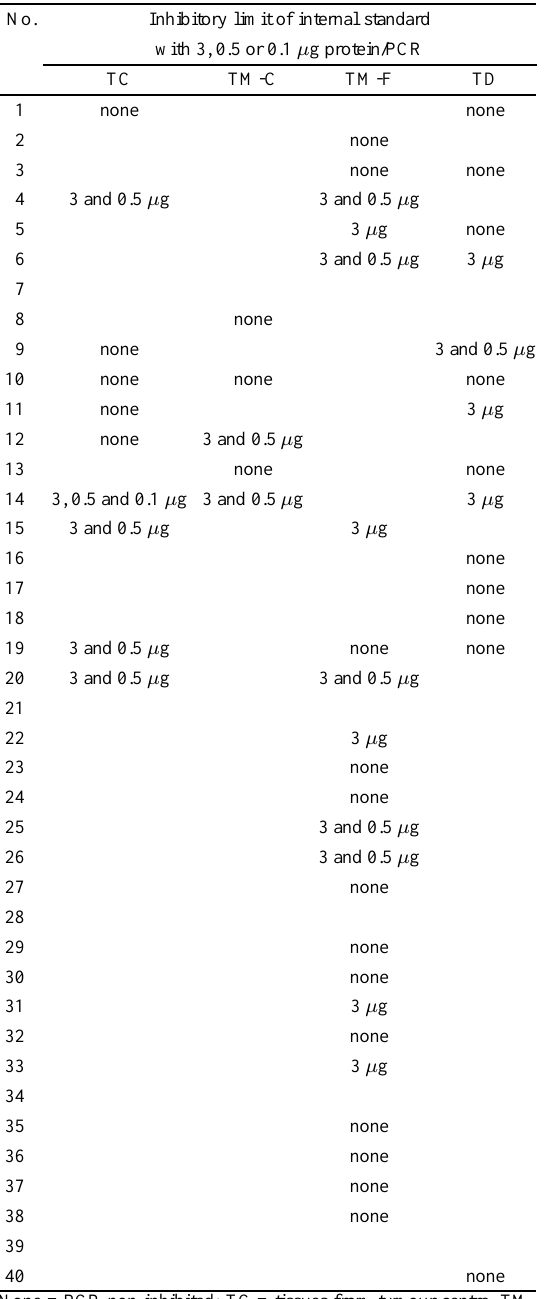
Examination of telomerase-negative tissue samples with the inter- nal standard from patients with head-and-neck squamous cell carci- noma (cf. 2.3.1. Material and methods as well as Tables 2 and